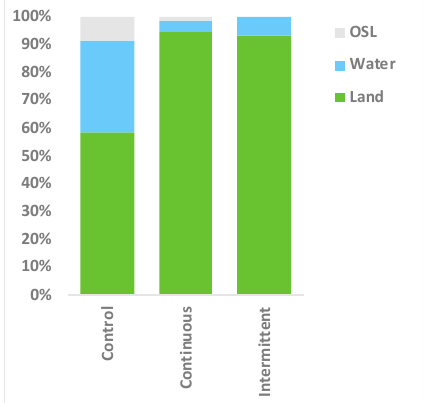
Figure 8. Time spent in water and on land by each alligator (mean % of time) in control, continuous and intermittent noise conditions. (OSL = Out of Sight).